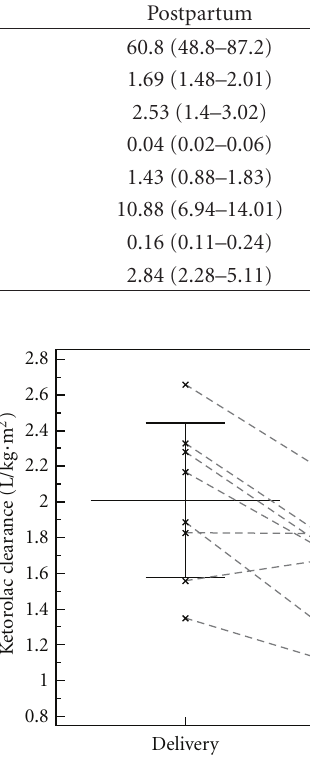
Figure 1: Paired intraindividual estimates for intravenous parac- etamol clearance at delivery or in postpartum (L/h · m 2 ) and mean with standard deviation for both time intervals.